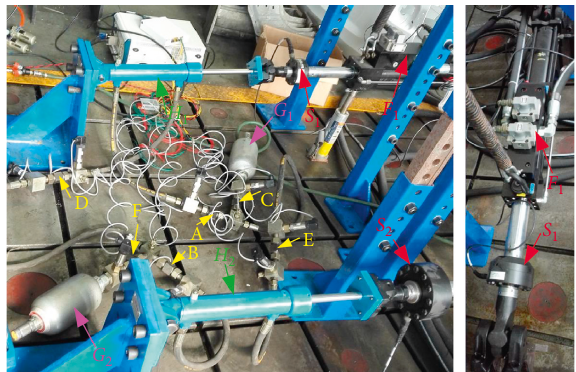
Figure 3: Test bench for the hydraulically interconnected sub- system. A–F: throttle valves; G 1 , G 2 : accumulators; H 1 , H 2 : hy- draulic cylinders; S 1 , S 2 : displacement sensors; and F 1 , F 2 : actuation